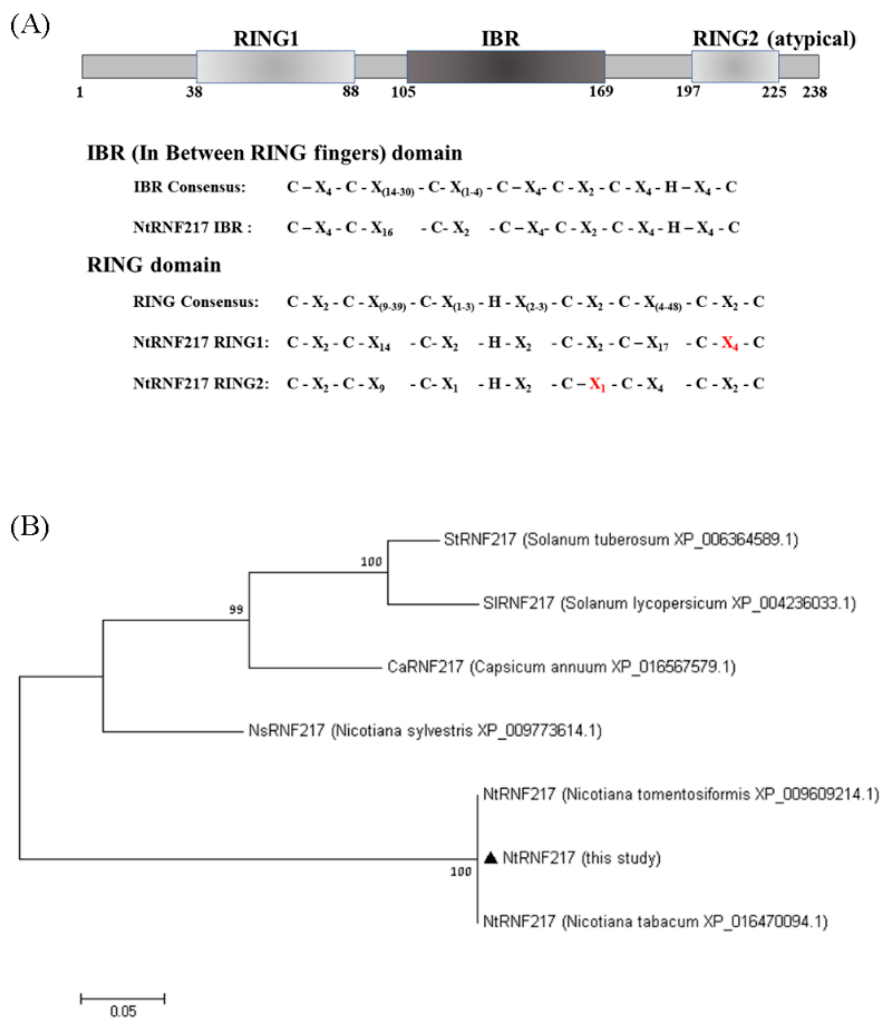
Figure 1. Sequence analyses of NtRNF217. ( A ) Diagram of the NtRNF217 protein with the functional domains annotated, and comparison of the domains to the consensus sequences. RING means Really Interesting New Gene; IBR means in between rings. ( B ) Phylogenetic tree of RNF217 protein sequences from different species. Values at the branches indicate the percentage of bootstrap support for 1000 resamplings.